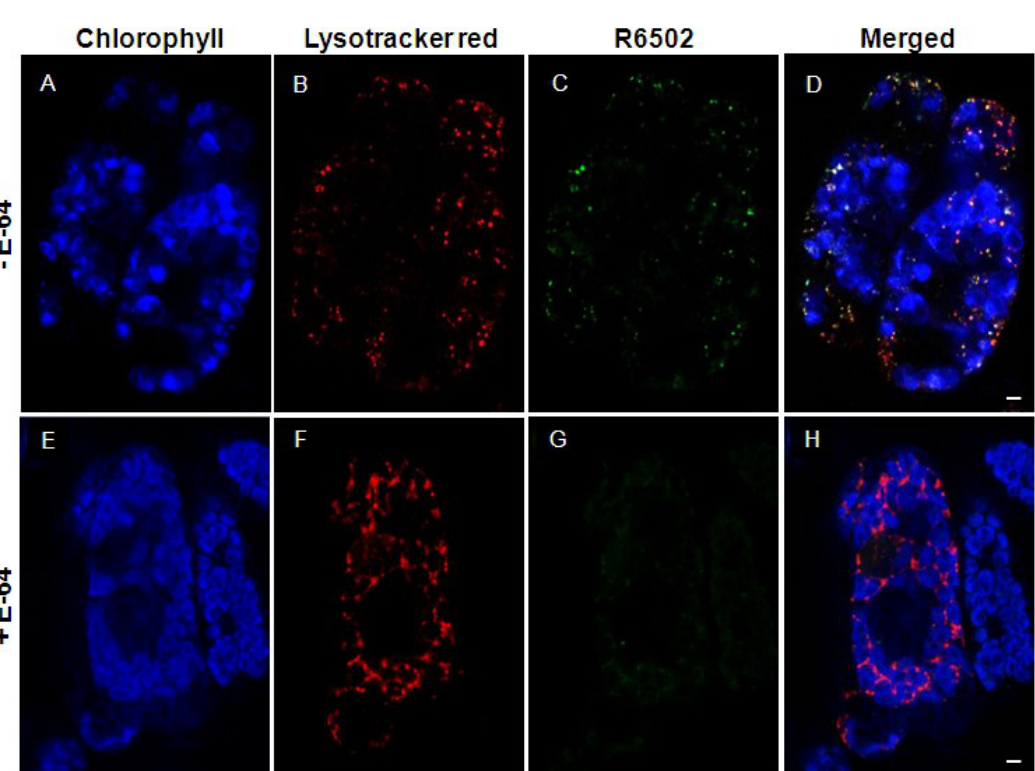
Figure 1. In vivo inhibition of cysteine protease activity of SAVs with the specific inhibitor E-64. Cells were isolated from senescing (3 days) tobacco leaves, and treated for 2 h with E-64 (100 µM, E through H), or left in buffer as controls ( A through D ). Cells were later stained with R6502, a probe for protease activity that becomes brightly fluorescent upon cleavage ( C and G ) and Lysotracker Red, an acidotropic marker for acid organelles ( B and F ). Panels A and E show chlorophyll autofluorescence, whereas panels D and H show a merged image of Chl, Lysotracker Red and R6502. Co-localization between Lysotracker Red and R6502 is pseudocolored white. Bars represent 5 µm. Redrawn from [54].